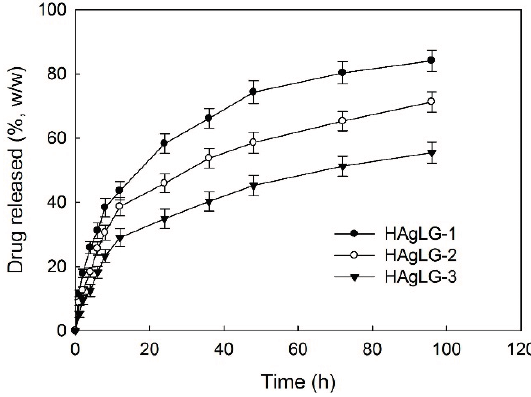
Figure 5. The effect of hyaluronidase addition on the drug release. To study the effect of hyaluronidase, hyaluronidase was added to release experiment of DOX-incorporated HAgLG polymeric micelles (5 mg of DOX-incorporated HAgLG polymeric micelles in dialysis tube with 5 mL PBS and 100 unit